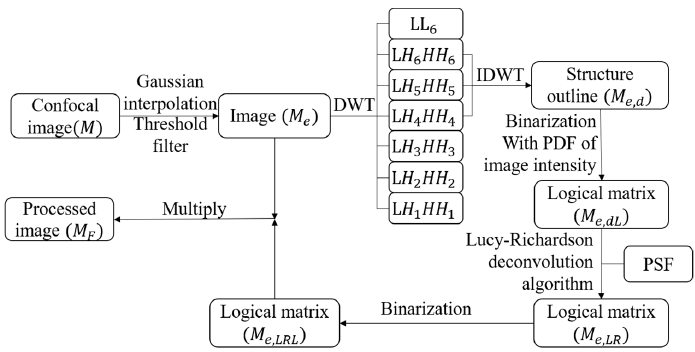
Figure 2. Schematic of DWDC method.